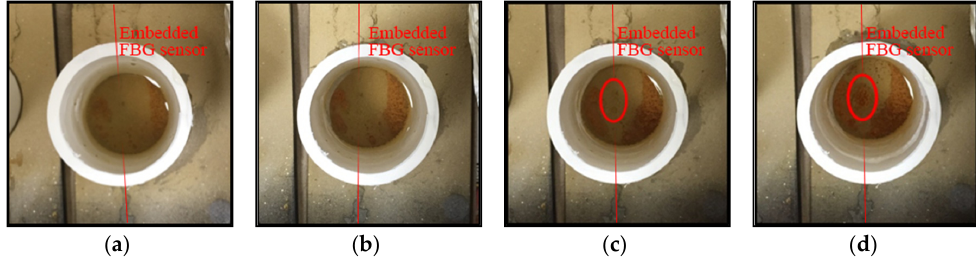
Figure 14. Visual inspections of Sample #1. ( a ) Day 1; ( b ) Day 2; ( c ) Day 3; ( d ) Day 6.